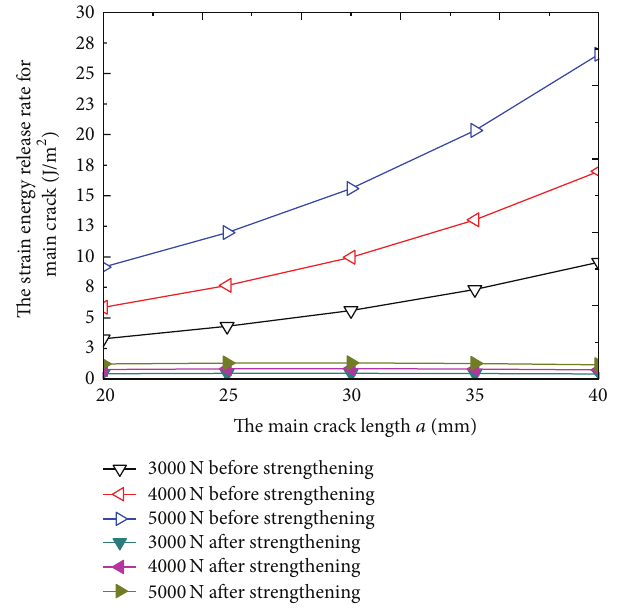
Figure 11: The comparison of SERR before and after strengthening.